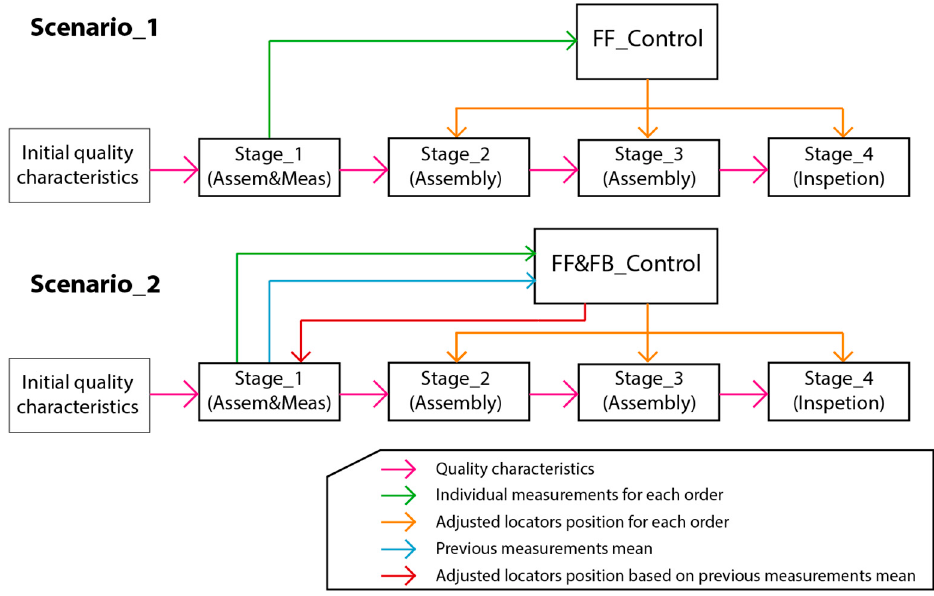
Figure 10. Scenario_1 and Scenario_2 process scheme.